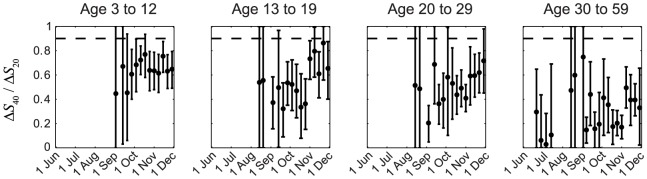
Age-specific ΔS
40/ΔS
20 during the first wave of pdmH1N1 in Hong Kong.ΔS
40 and ΔS
20 at each cross-section were estimated using the method described in our previous work [11]. If ISP20 and ISP40 (among all pdmH1N1 infections) were the same as the proportions of clinical cases that became MN1:20 and MN1∶40 seropositive (i.e. around 100% and 90%, respectively [23], [24]), ΔS
40/ΔS
20 should have remained close to 0.9–1 (the horizontal dashed line) throughout the first wave, which was not the case in reality as shown here.